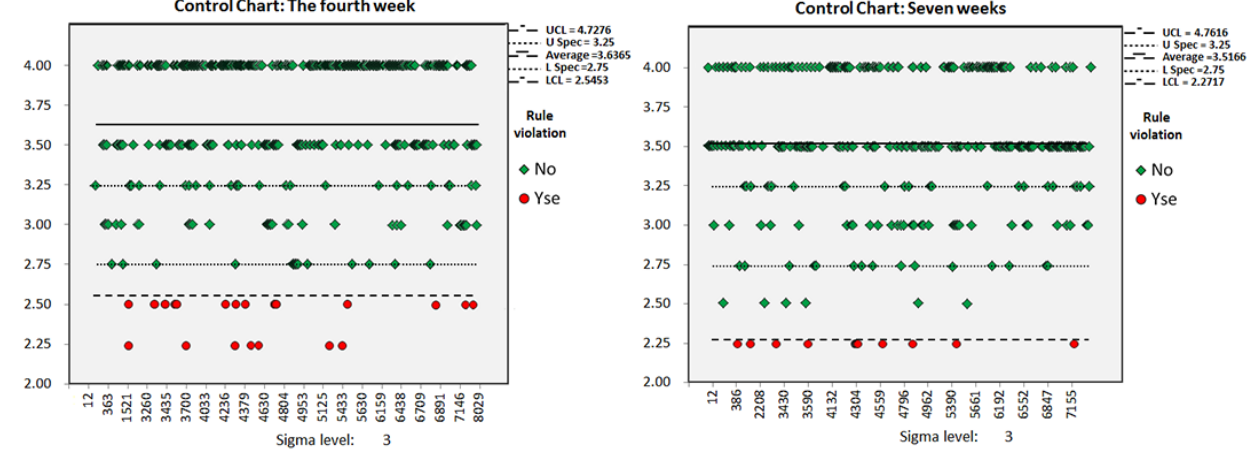
Figure 4. Example of the individual control chart for each BCS of all dry cows in the fourth ( left ) and seventh ( right ) week. The red (alarm) points represent out-of-control observations.